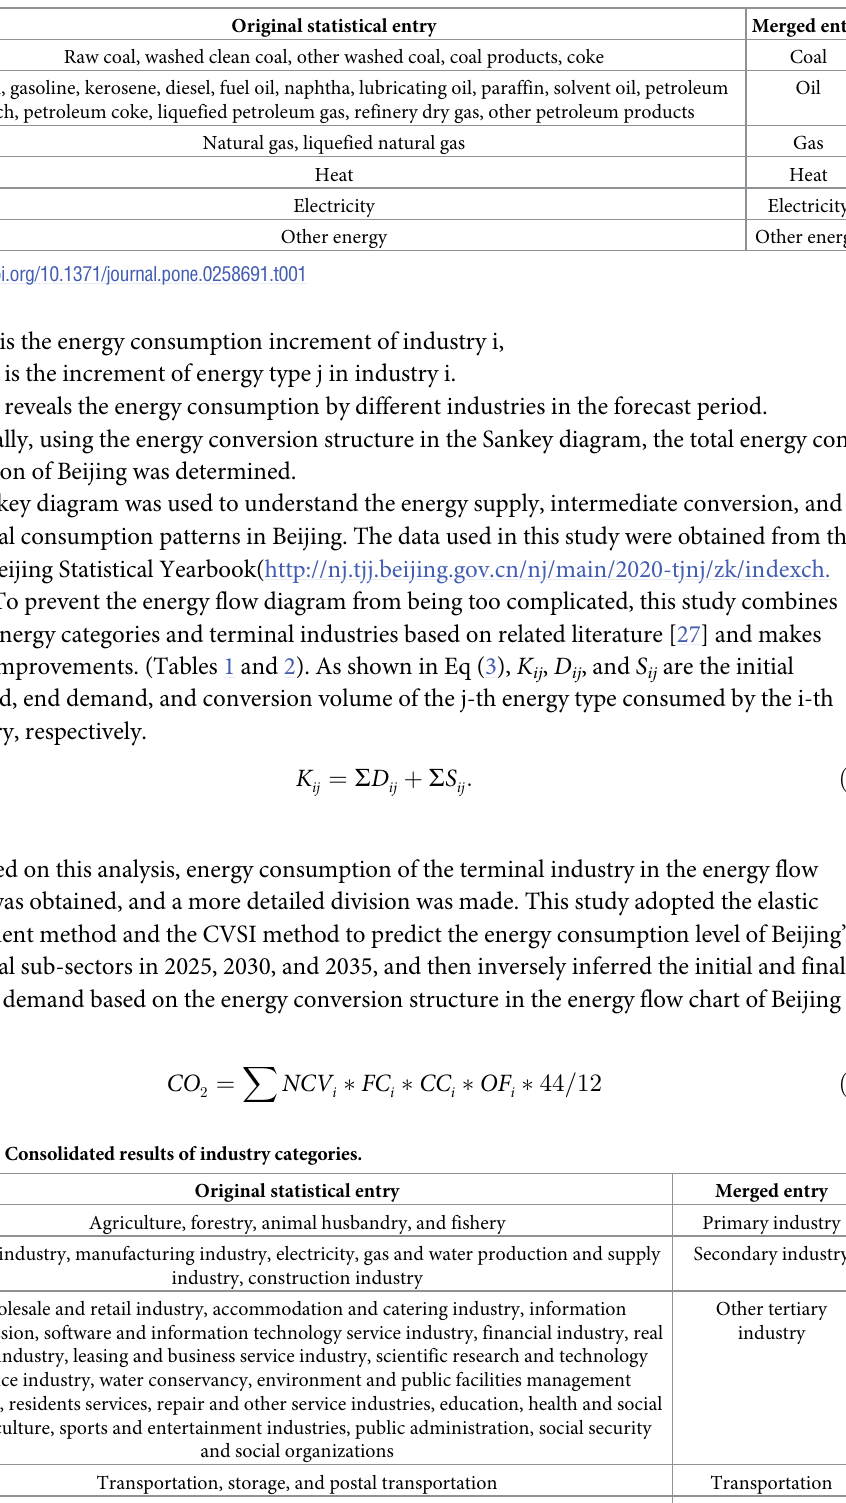
Table 1. Consolidated results of energy categories.